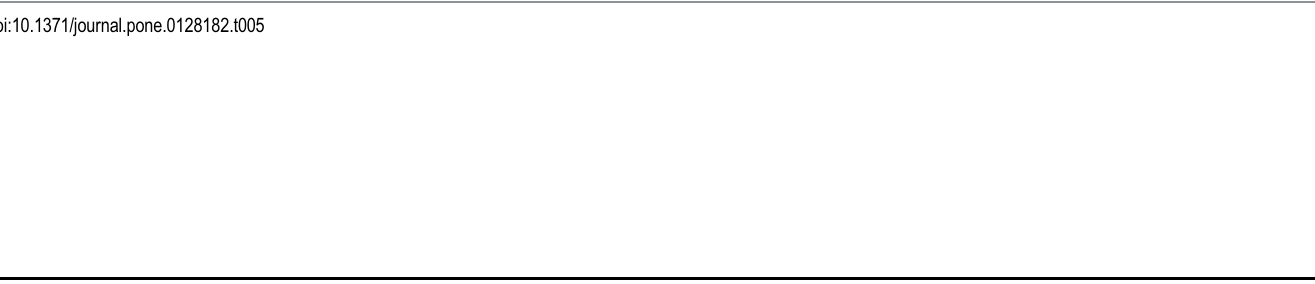
Models are ranked by differences in Akaike ’ s information criterion and only candidate models within Δ AIC cd (cid:3) 4.0 are presented. Model selection results are followed by model averaging results for each species. The R 2 represents the model fi t for the estimated daily individual abundance vs. model averaged predicted